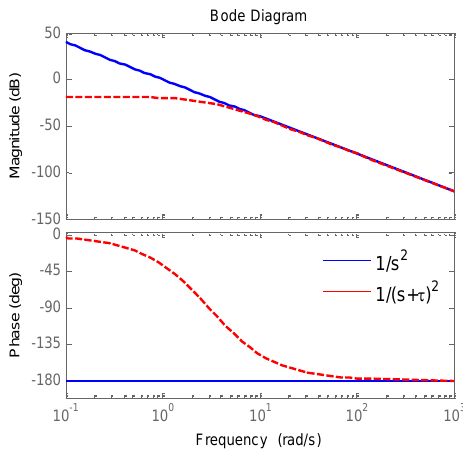
Figure 8. The comparison between the double-integrator and estimator.